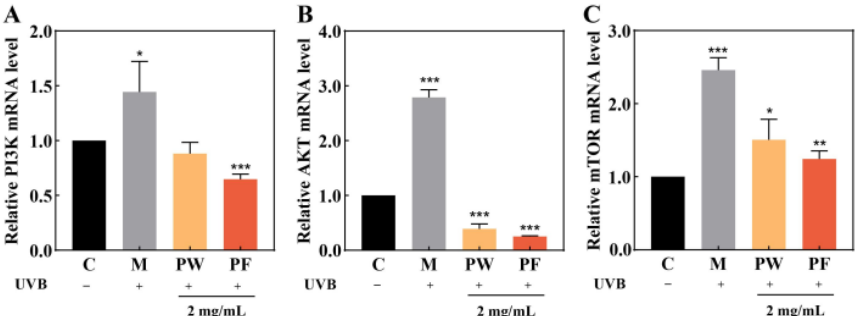
Figure 8. Effects of 2 mg/mL of PF on cellular PI3K/AKT/mTOR pathway gene expression. (A) Rel- ative expression of PI3K in HaCaT cells; (B) Relative expression of AKT mRNA in HaCaT cells, (C) Relative expression of mTOR mRNA in HaCaT cells. PW: Passiflora edulis Sims aqueous extract. PF: Passiflora edulis Sims peel fermentation broth. C: control group. M: UVB damage model group. Each